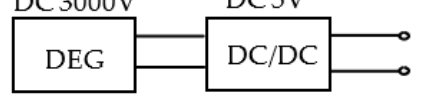
Figure 9. HOLTEK DC/DC converter IC.